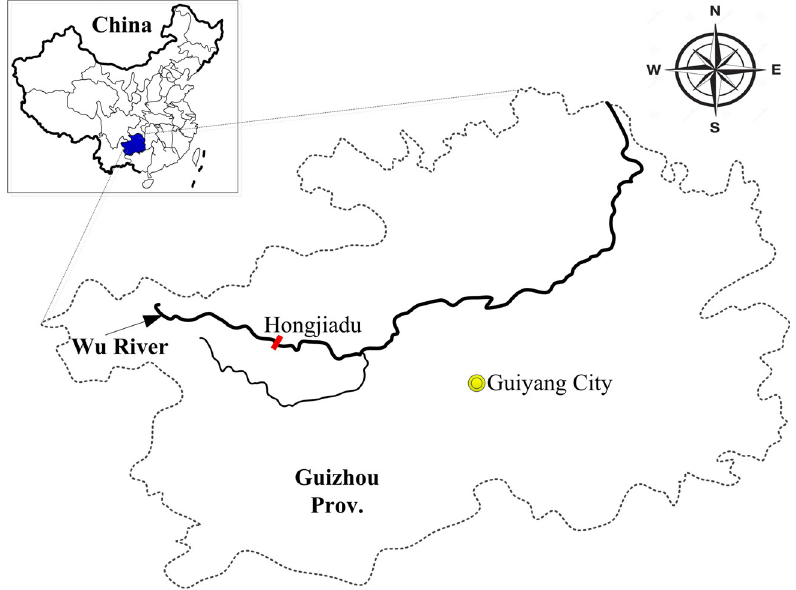
Figure 3. Location of study